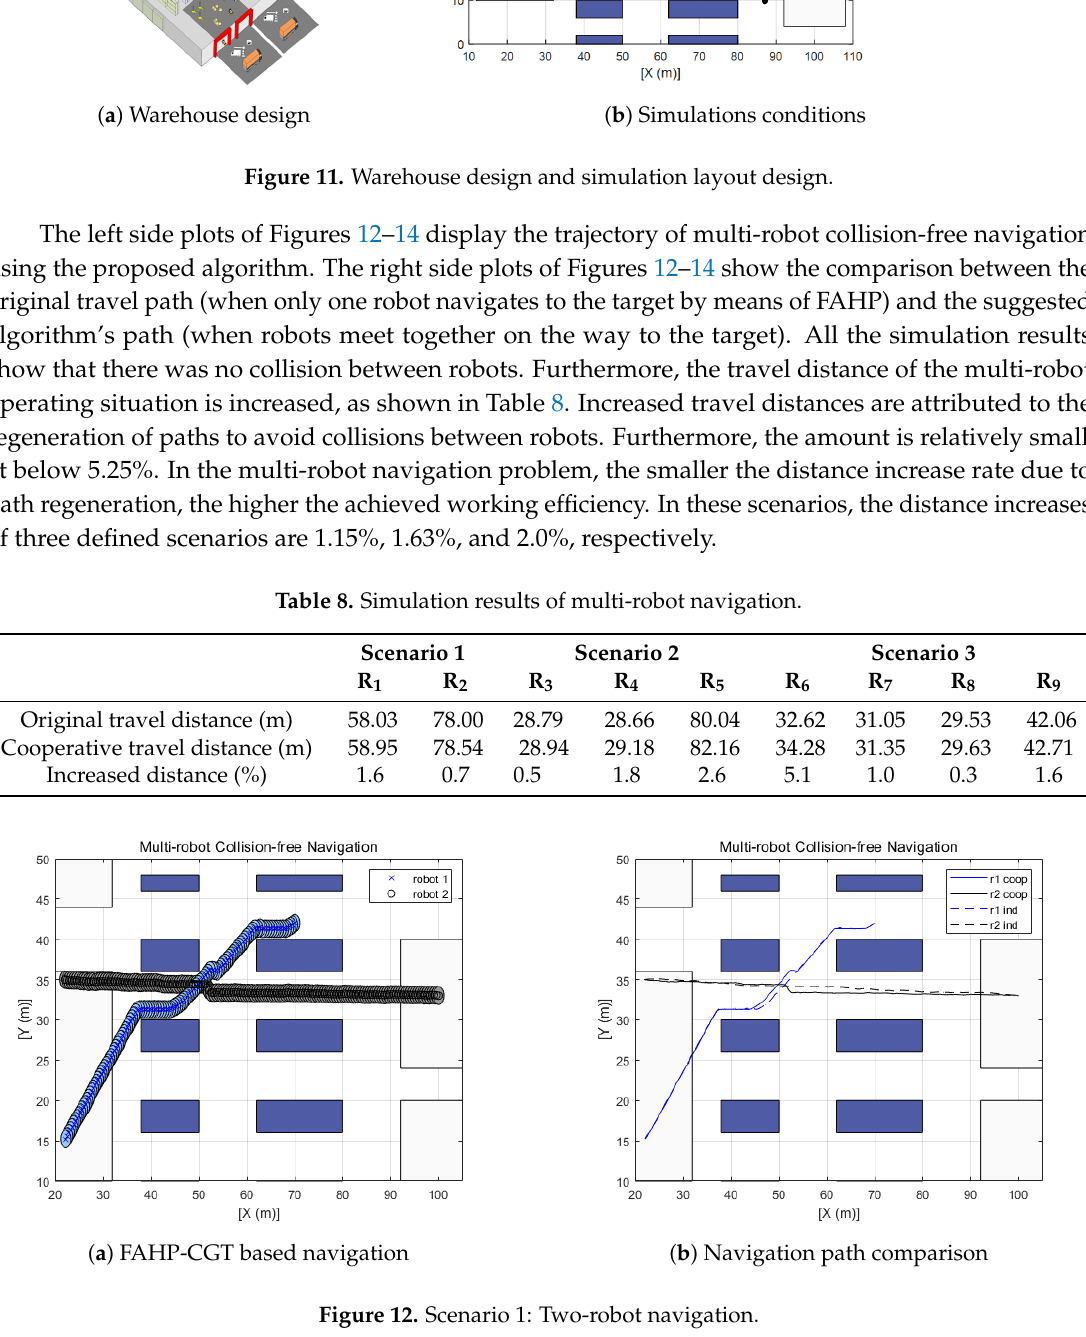
Figure 12. Scenario 1: Two-robot